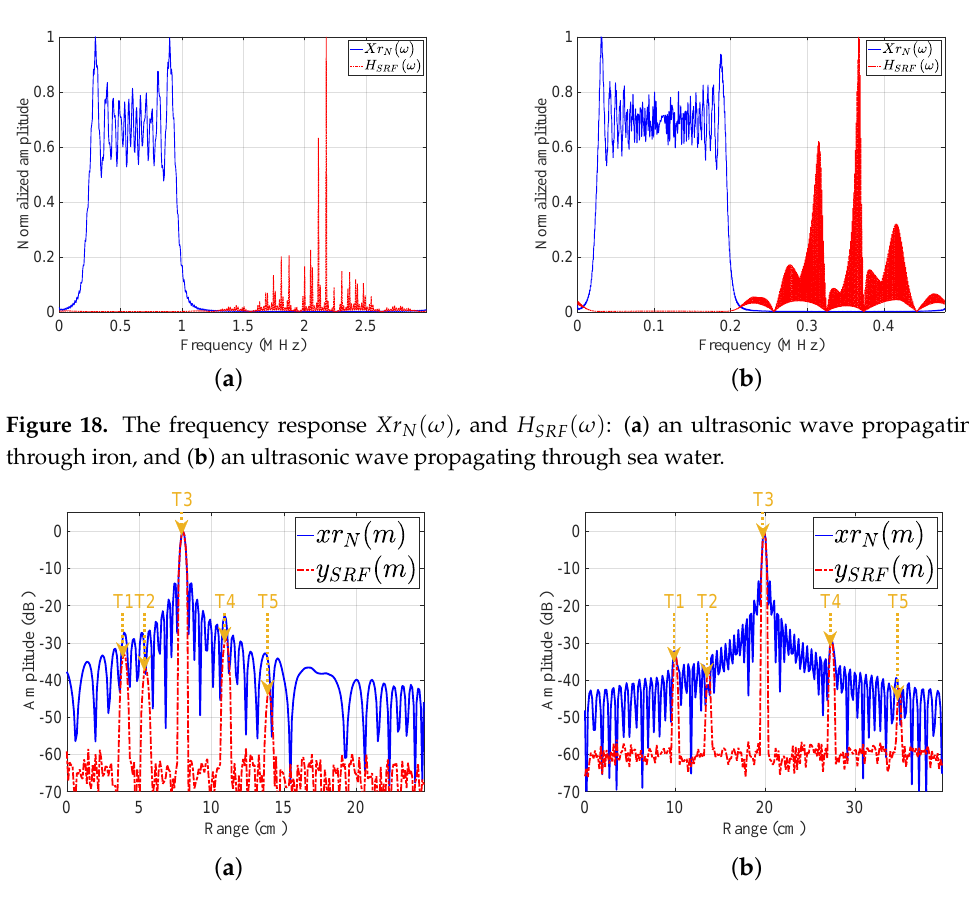
Figure 19. The amplitude responses of the MF and the proposed EMF for different values of LFM waveform parameters: ( a ) an ultrasonic wave propagating through iron, and ( b ) an ultrasonic wave propagating through sea water.